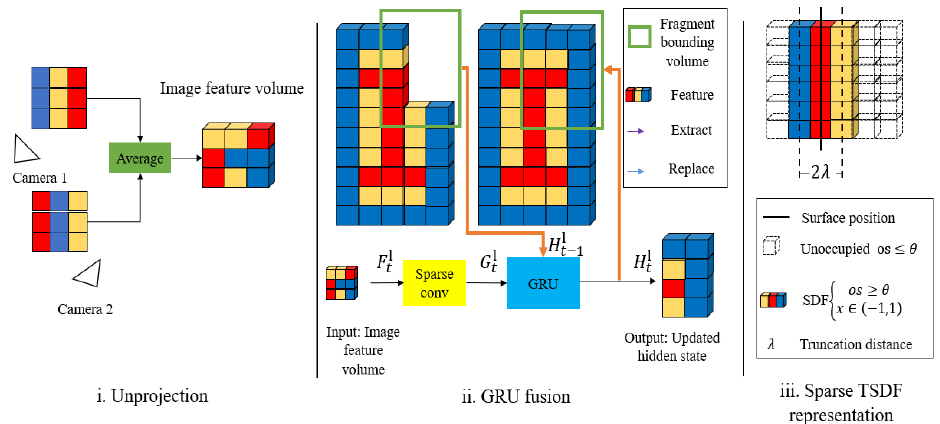
Figure 6. Illustration of unprojection, GRU fusion, and sparse TSDF representation. λ is the TSDF truncation distance.